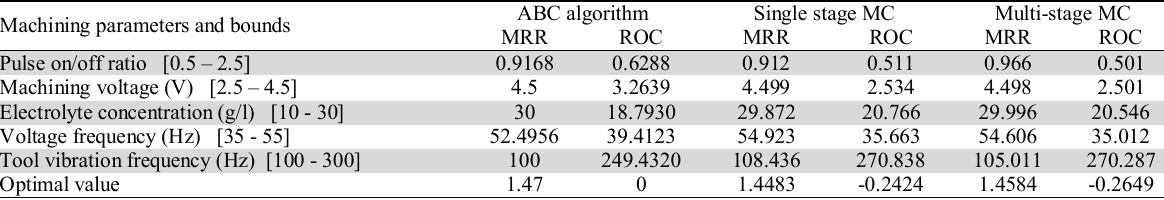
Optimization solutions of case study